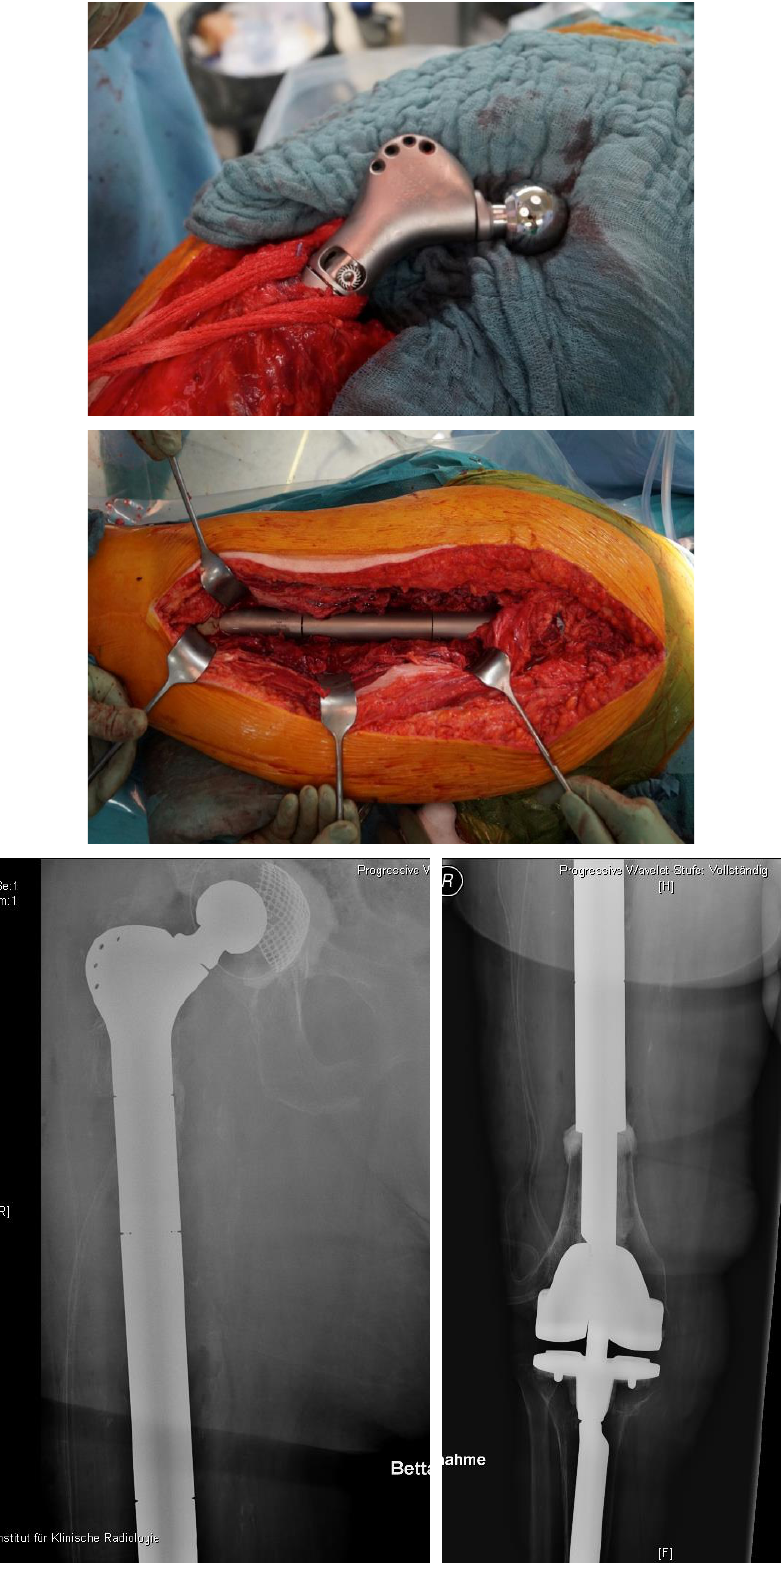
Figure 6. Interprosthetic fracture around a stable total knee revision arthroplasty and a loose total hip revision arthroplasty. Implantation of a custom-made docking sleeve coupled to a proximal femur replacement (AQ-Implants GmbH, Ahrensburg,